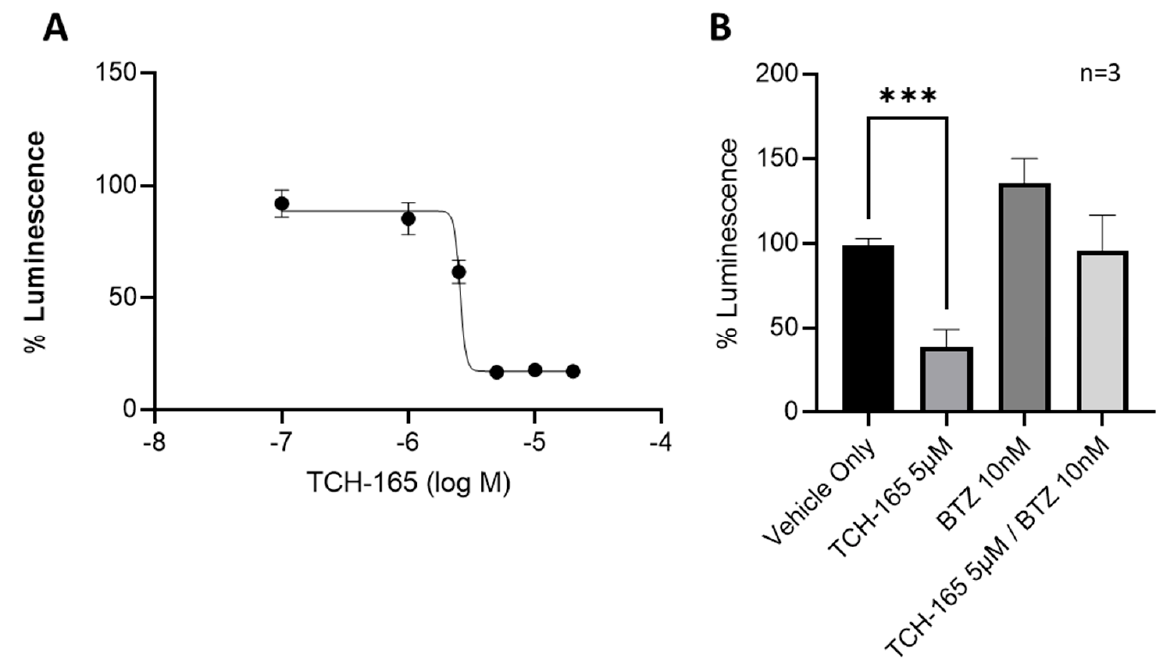
Figure 3. MYC-luciferase reporter assay: ( A ) MYC-luciferase reporter assay in stable transfected HCT-116 cells treated with various concentrations of TCH-165 (EC 50 2.57 μ M; 95% CI 2.46–2.95); ( B ) MYC-luciferase reporter assay in stably transfected HCT-116 cells treated with vehicle, TCH-165 (3 μ M), bortezomib (BTZ, 10 nM) and bortezomib (2 h pre-incubation, 10 nM) followed by TCH-165 (3 μ M). *** p < 0.001.